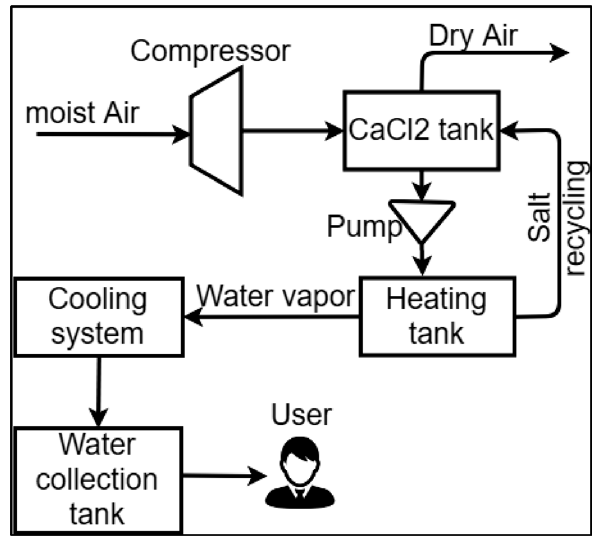
Scheme 2. General operation diagram of the